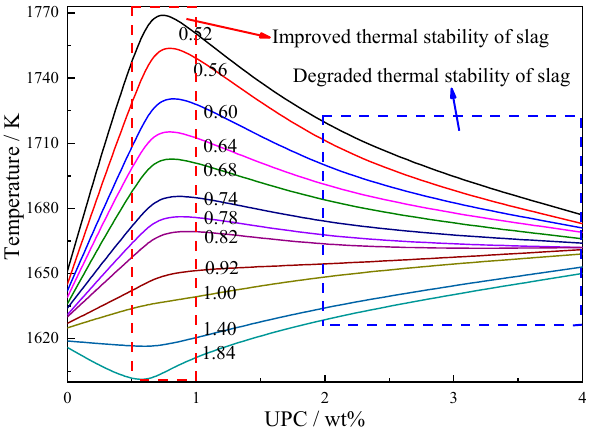
Figure 6. Influence of the UPC content and temperature on the BF slag viscosity.